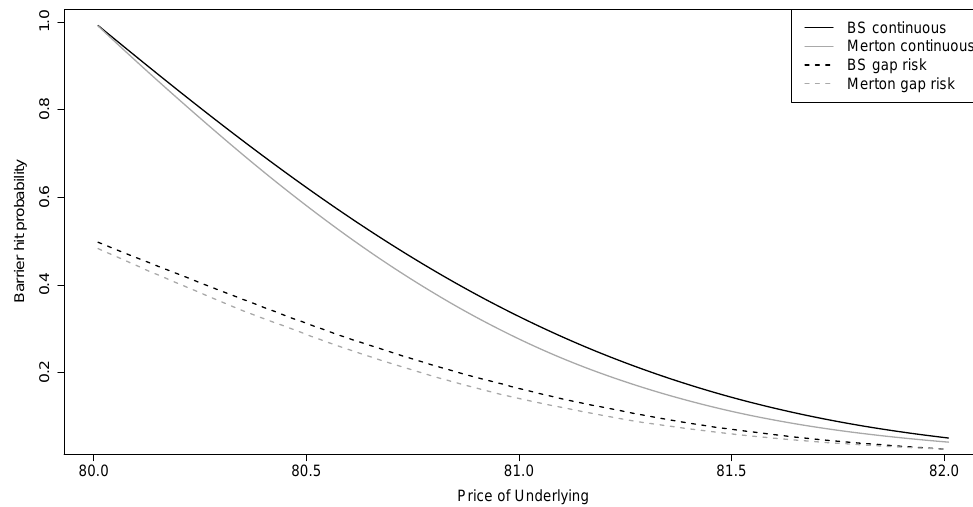
Figure 3. Probability of barrier crossing between t = 0 and t = 1 day. The barrier is at B = 80. The graphs show the probabilities dependent on the underlying price for continuous trading (solid lines) and with overnight trading gap (dashed lines); in the Black–Scholes model with geometric Brownian motion (black lines) and in the Merton model with jump diffusion (grey